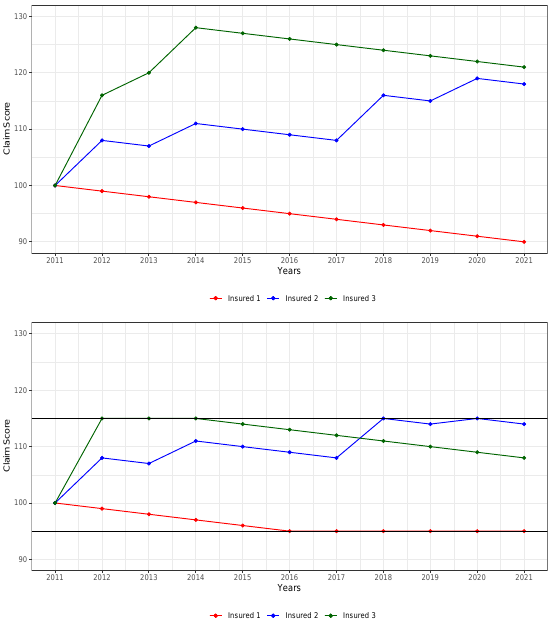
Figure 1. Insureds with claim experience, with and without limits (cid:96) min , (cid:96) max